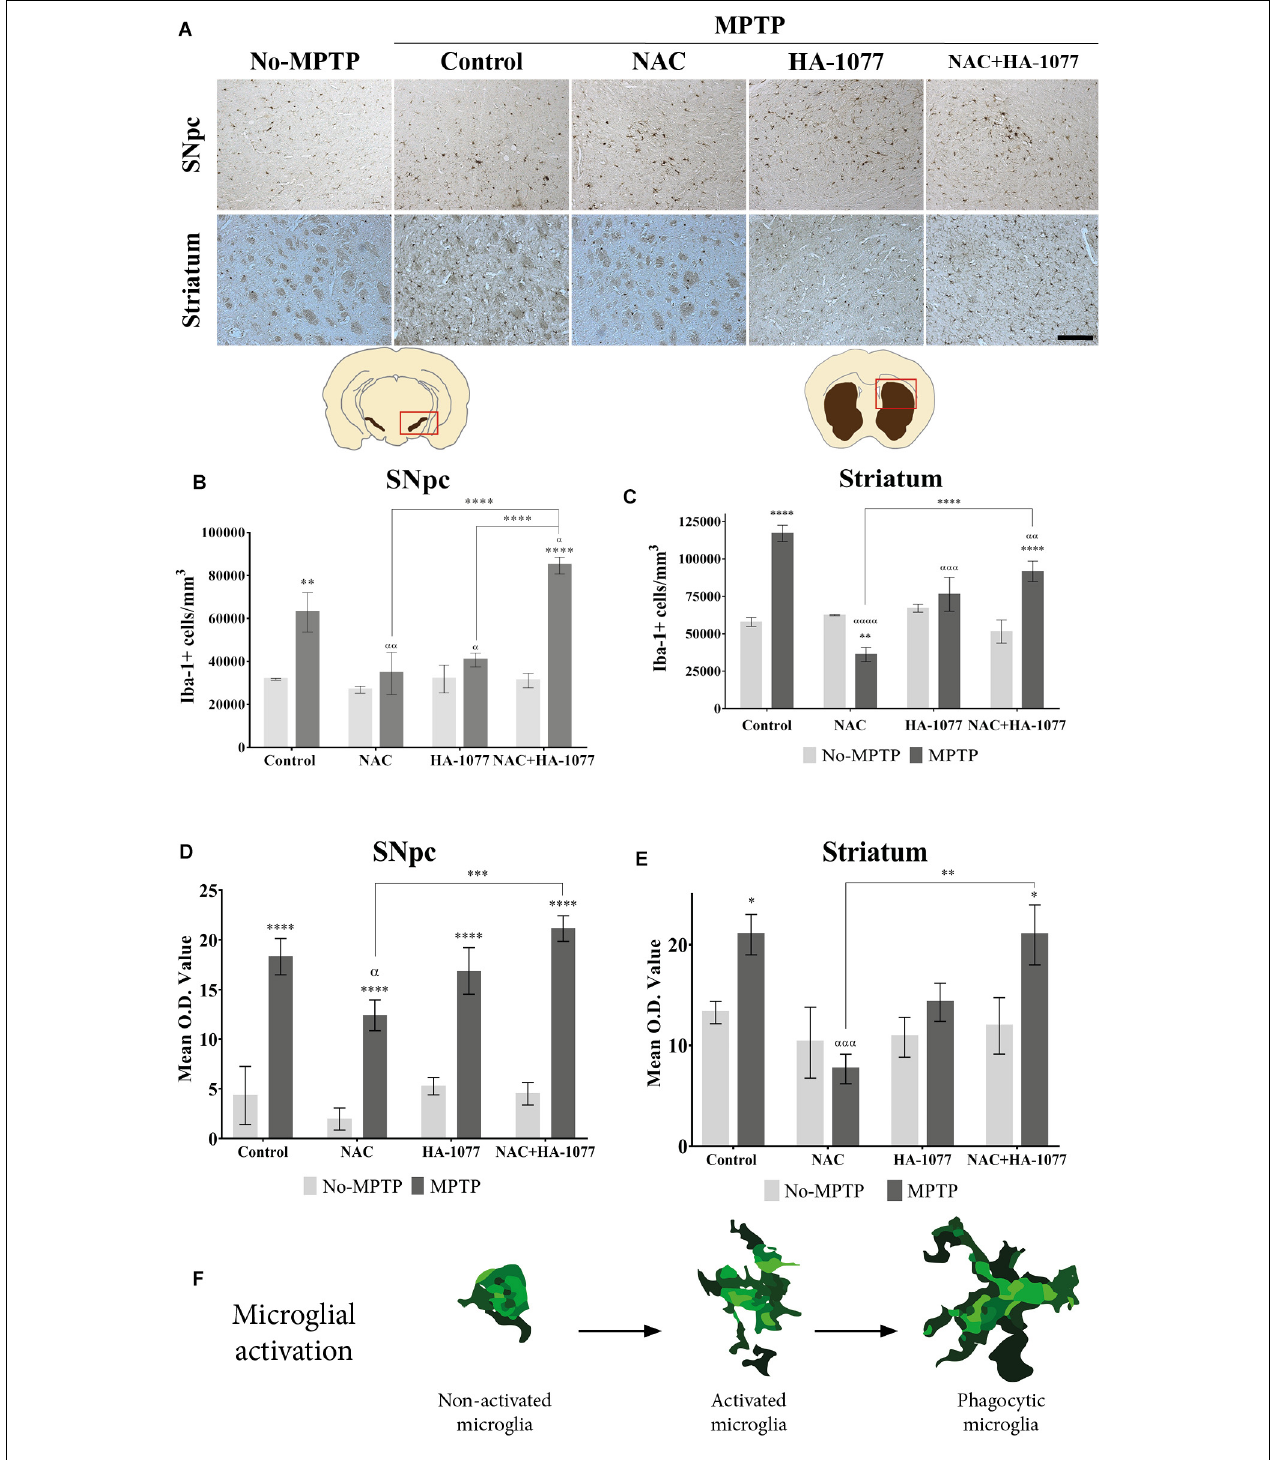
FIGURE 3 | Iba-1 + cell count depends on different treatments in old-Parkinsonian mice. (A) Immunohistochemical staining with Iba-1 of coronal sections of SNpc and striatum (Magnification 20 × , Scale bar = 100 µ m). (B) Quantification of Iba-1 + cells in the SNpc by immunostaining analysis. The results showed a significant increase of Iba-1 + cells in MPTP treated mice ( ∗∗ p = 0.002) and very significant in MPTP + NAC + HA-1077 ( ∗∗∗∗ p < 0.0001) compared with their control groups. MPTP vs. MPTP + NAC ( αα = 0.0020); vs. MPTP + HA-1077 ( α = 0.0196); and, vs. MPTP + NAC + HA-1077 ( α = 0.0222). MPTP + NAC + HA-1077 vs. MPTP + NAC ( ∗∗∗∗ p < 0.0001) and vs. MPTP + HA-1077 ( ∗∗∗∗ p < 0.0001). (C) Mean O.D. value measurement for Iba-1 + cells in the SNpc for the